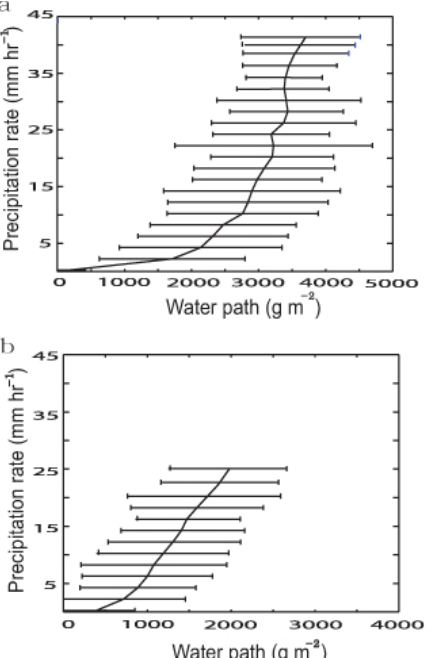
Fig. 4. Averaged WP for (a) the high-aerosol run and (b) the control run. Vertical bars represent ± 1 standard deviation.